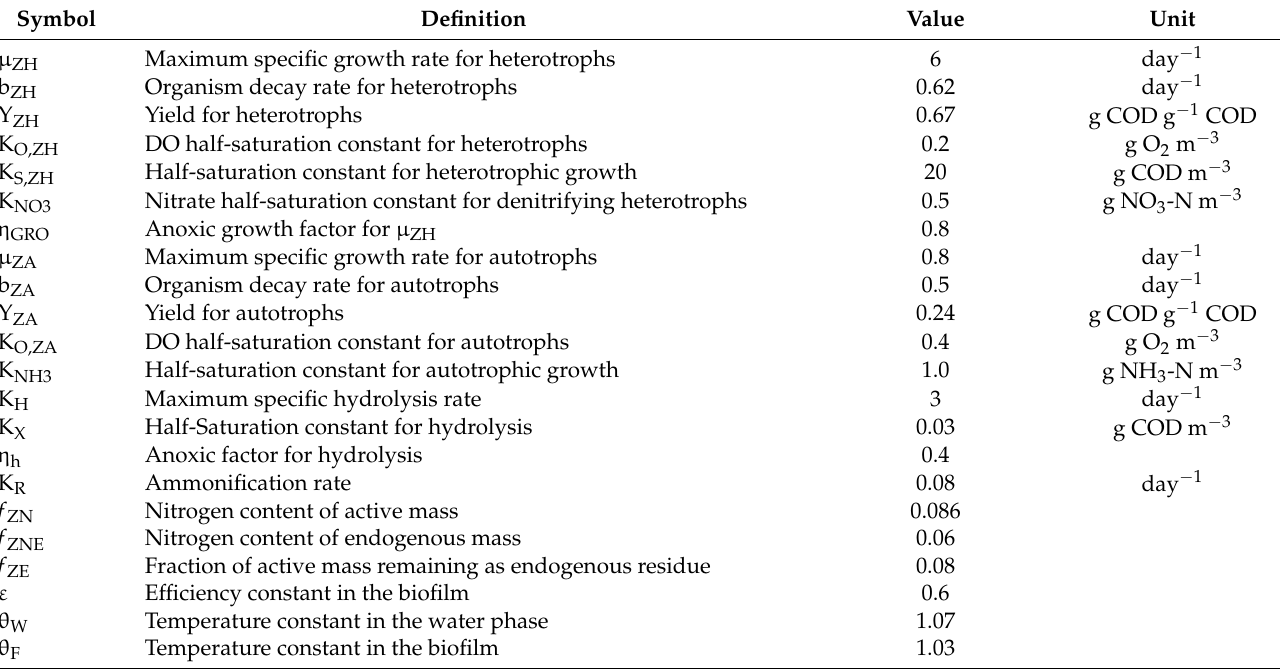
Figure 2. Computer program flow chart. Table 4. Constant values.